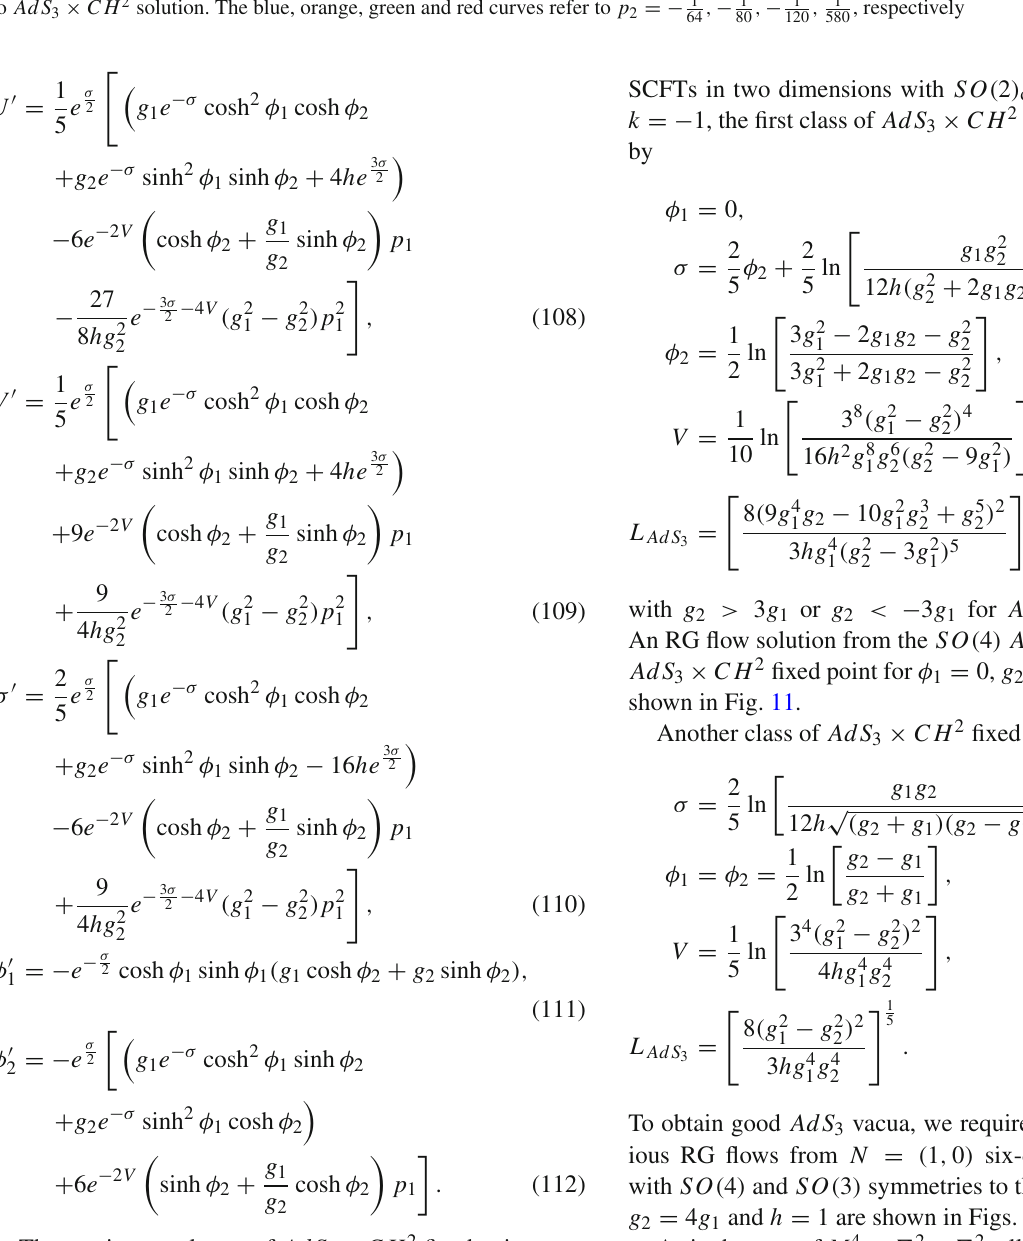
, − 1 , − 1 , 1 , 64 80 120 580